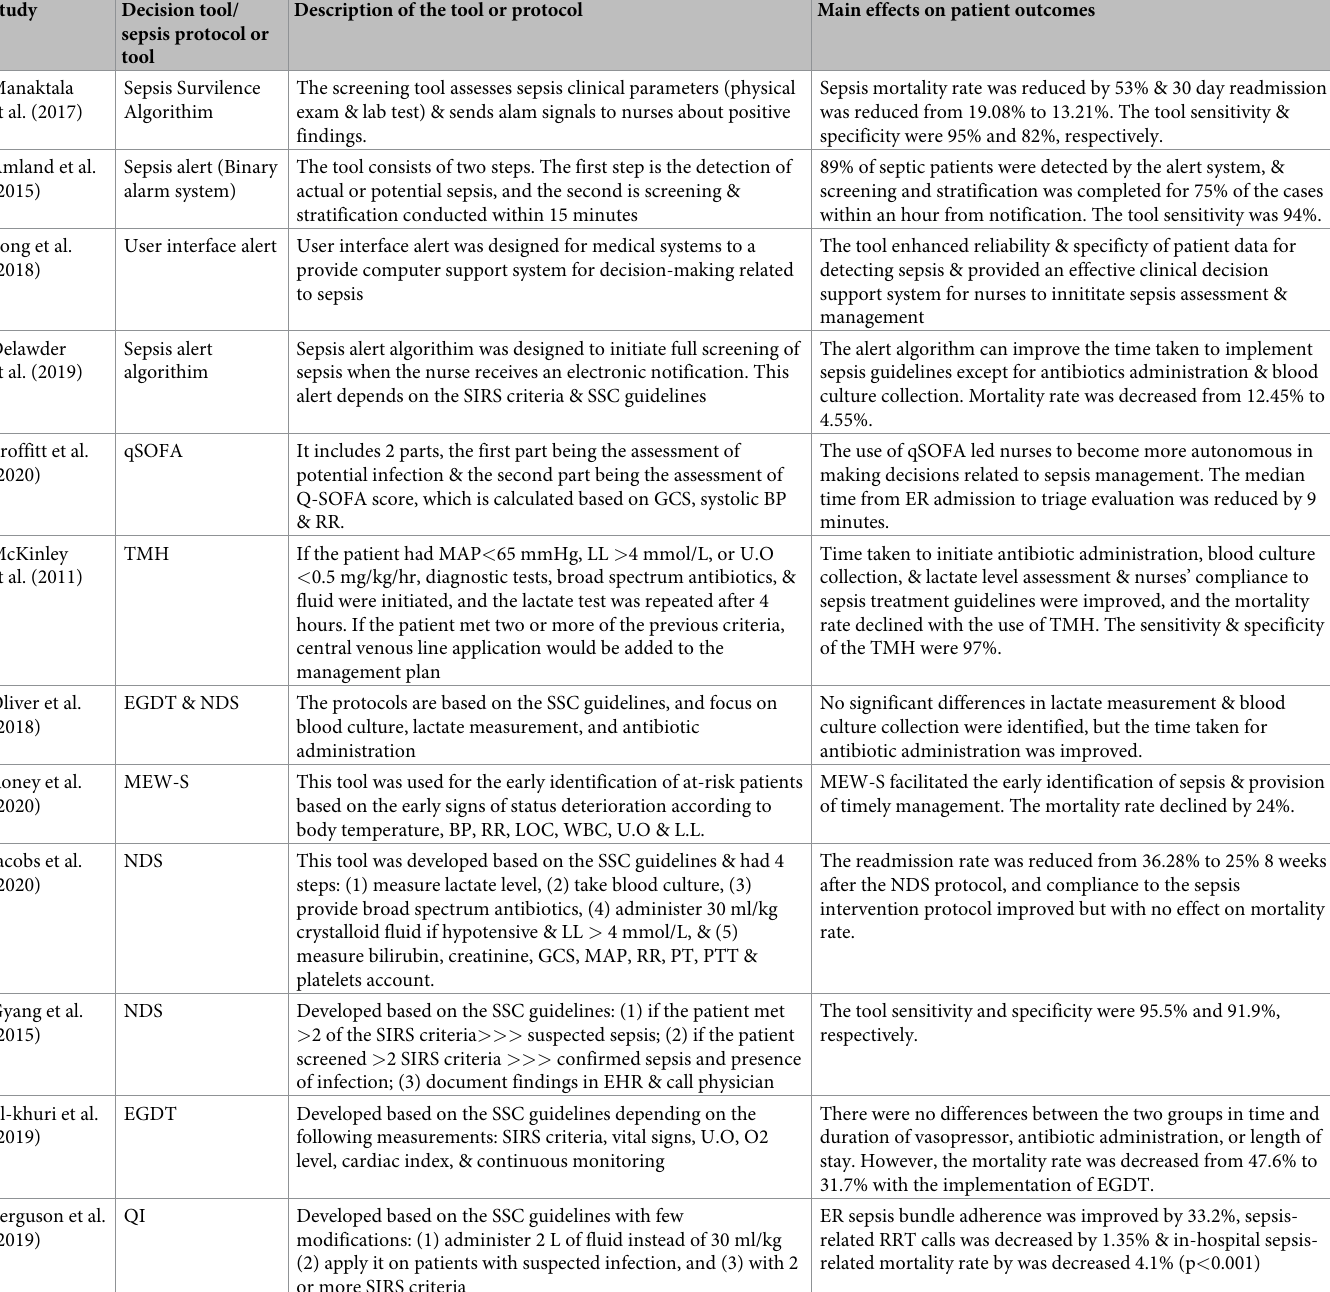
Table 7. Sepsis decision-making support and screening tools and treatment